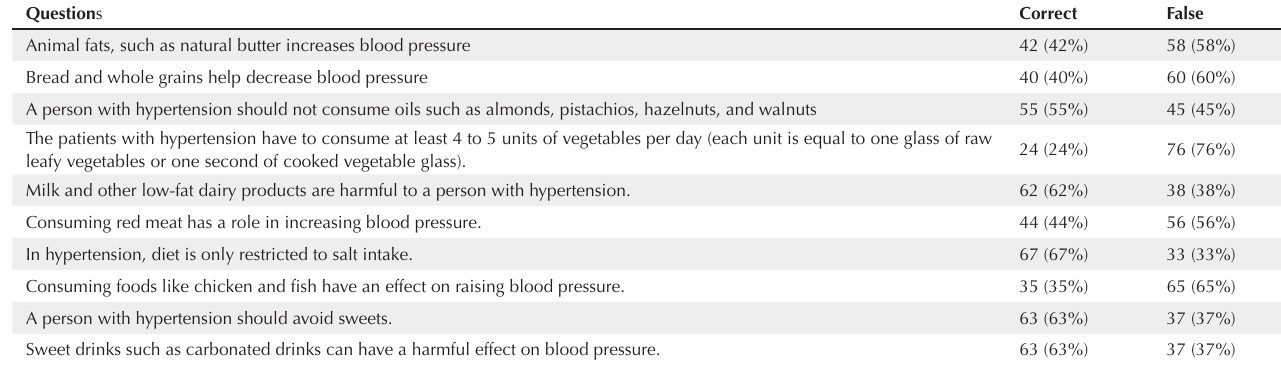
Table 1. Questions and Percentage of Responses Related to Nutritional Awareness of Patients With Hypertension Question s